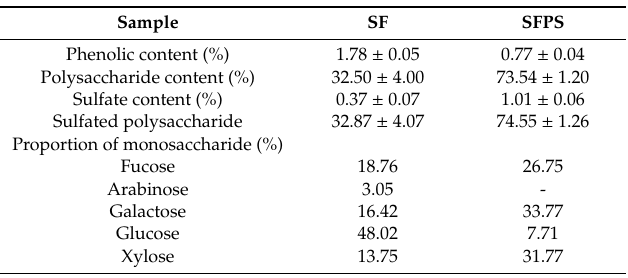
Table 1. Components of Celluclast-assisted extract of Sargassum fulvellum (SF) and polysaccharides of SF (SFPS) obtained from S.